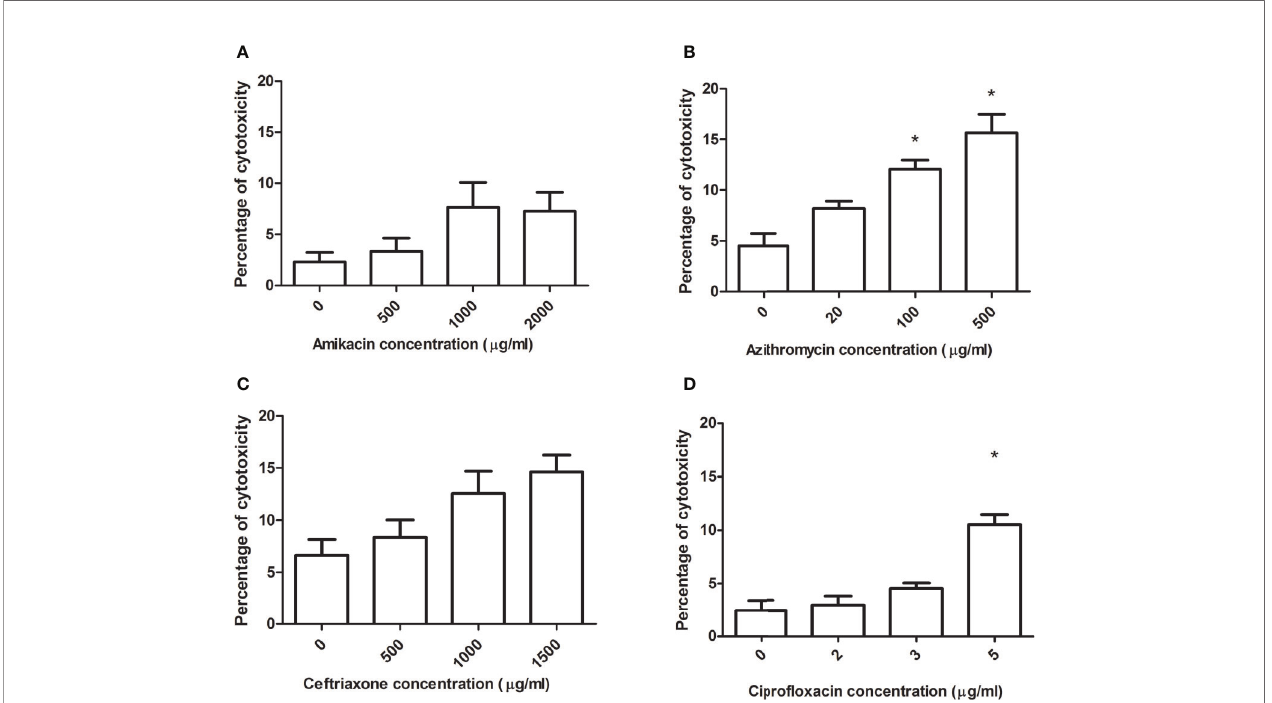
FIGURE 6 | Antibiotic cytotoxicity over the cell monolayer. Each antibiotic concentration was evaluated on the monolayer during 10 h of incubation. Using MLC, the total number of cells per fi eld and the number of dead cells was observed, and the percentage was calculated. (A) Cytotoxicity for the different concentrations of amikacin (AK), (B) azithromycin (AZ), (C) ceftriaxone (CRO) and (D) cipro fl oxacin (CIP). The results were compared using the Mann-Whitney statistical test, and it was considered signi fi cant when the p-value ≤ 0.05. *Signi fi cant differences respect to